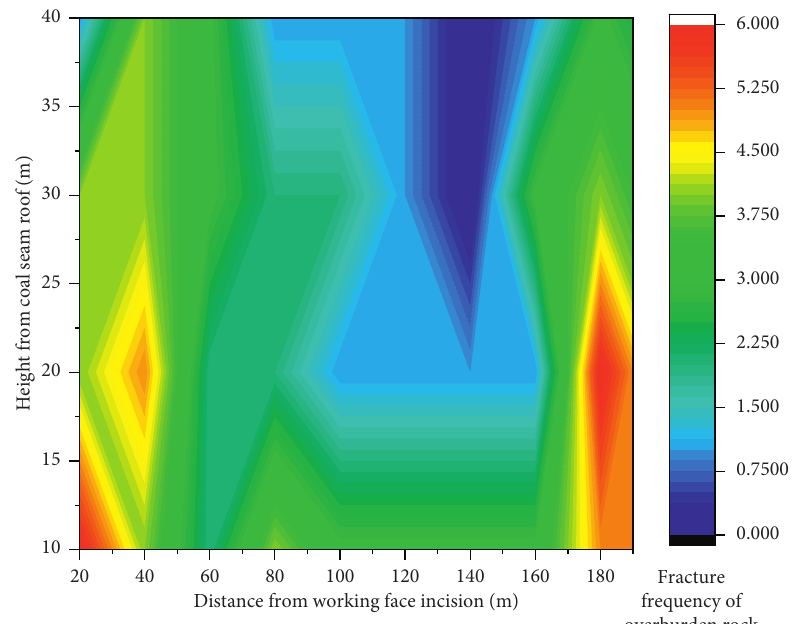
Figure 5: Distribution of fracture